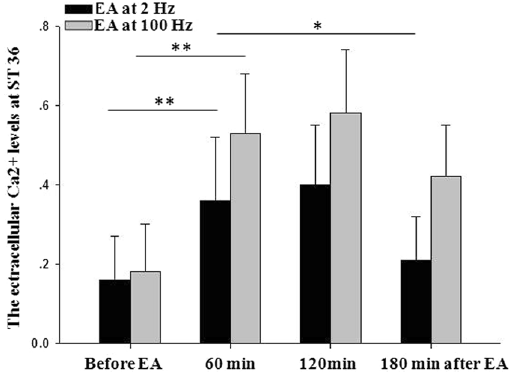
Figure 2. Extracellular Ca 2 + levels at acupoint ST 36 under electroacupunture. The Ca 2 + level at acupoint ST 36 increased significantly during 2Hz-EA ( p = 0.003 vs. pre-EA). The Ca 2 + level continued to increase till 60 minutes after EA, and then started to decrease in post-EA at 120 minutes ( p = 0.04 vs. EA). Similar to the situation under 2 Hz, the extracellular Ca 2 + concentrations also increased significantly under high frequency (100 Hz) EA, and the increase started to decrease 120 minutes after EA. The difference between low and high frequencies (2 vs 100 Hz) did not reach significance. Compared with extracellular Ca 2 + levels during EA, * p < 0.05, ** p < 0.01, Two-way ANOVA followed by Duncan post hoc tests.